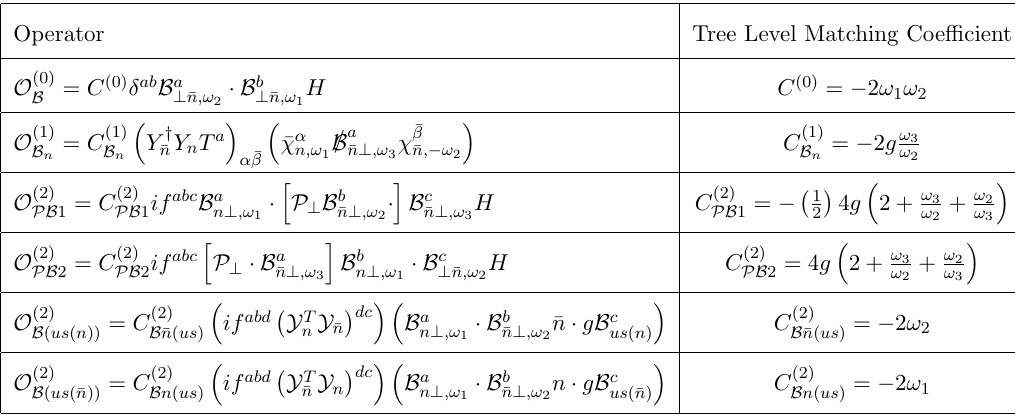
( (cid:21) 2 ) in gluon O